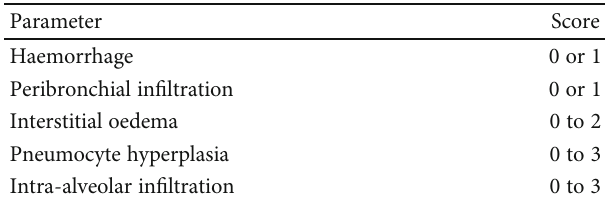
Table 1: Lung injury evaluation